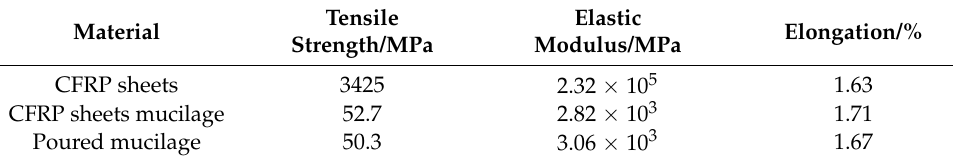
Figure 3. Loading history. 2.3. Specimen Pre-Damage and Reinforcement The pre-damage parameters and reinforcement methods of the specimens are shown in Table 3. The specimen KJD-0 was not strengthened and specimen KJD-1 was reinforced directly without pre-damage. Specimens KJD-2 and KJD-3 were pre-damaged by quasi- static test to achieve a moderate damage and a severe damage of the reinforced concrete pier grade 5 performance class, respectively [20]. When the horizontal displacement reached 36 mm in the third cycle, cracks appeared at the column and joint of KJD-2, which was designated as moderate damage. When the specimen KJD-3 was loaded to ±63 mm in the first cycle, and the original cracks of joints and column foot extended, the concrete cover of the bottom column foot began to fall off, and the horizontal bearing capacity reached the peak load, which was designated as a severe damage. The hysteretic curves of pre-damage specimens are shown in Figure 4. −ΝΔ y … − 1.5 Δ y −Δ y … -6-4-2